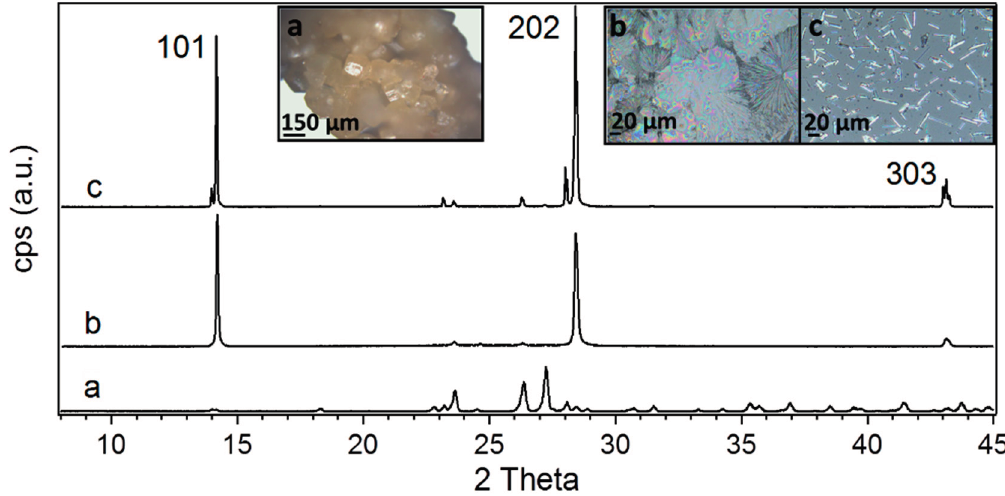
Figure 3. Powder X-ray diffractograms of thin-layered films cast from ethanol-based suspensions of HI 3 O 8 : ( a ) as-received; ( b ) needle-like; and ( c ) rod-like shaped crystals. Films (b) and (c) were produced by storing deposited films at ~40% relative humidity for a few weeks. Inset: Optical microscopy images of (a), (b), and